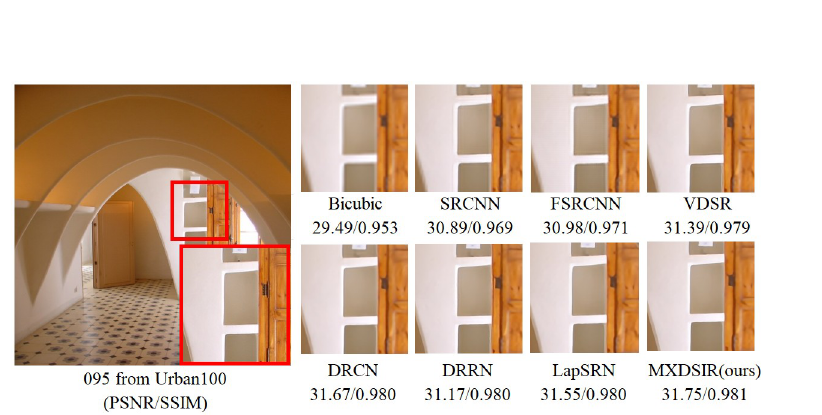
Fig 7. Visual performance of images with 8 × enlargement factor of image 095 from Urban100 dataset.